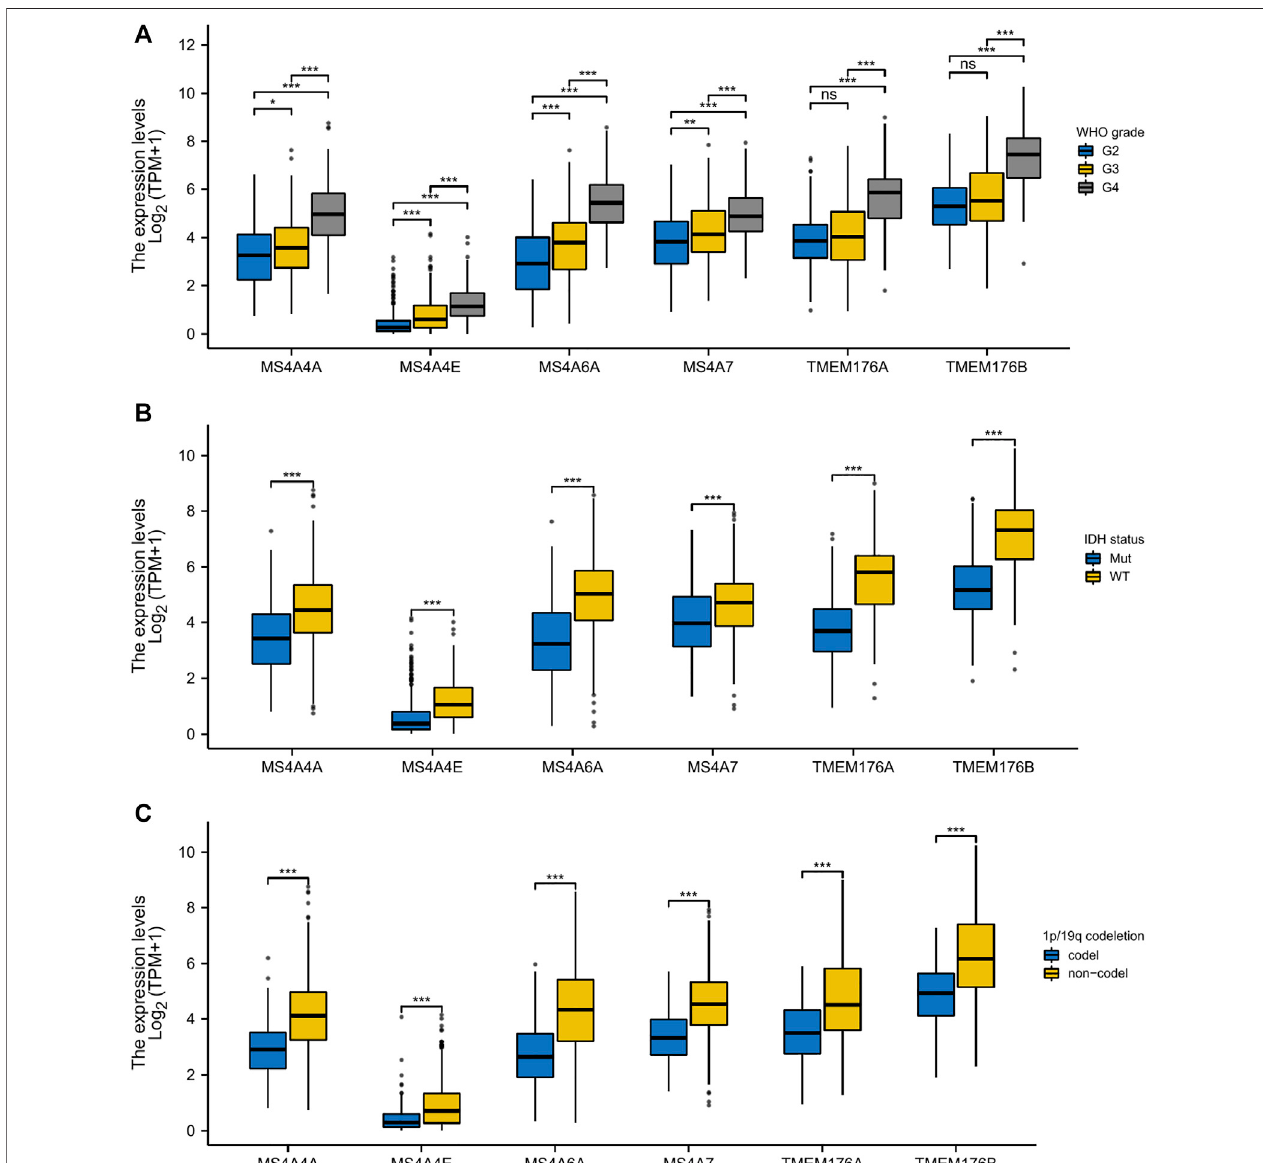
FIGURE2| RelationshipbetweenMS4A mRNAlevel and clinicopathological parametersinglioma [ (A) WHO grade; (B) IDHstatus; and (C) 1p/19q codeletion]. p - value: 0 ≤ *** < 0.001 ≤ ** < 0.01 ≤ * < 0.05.